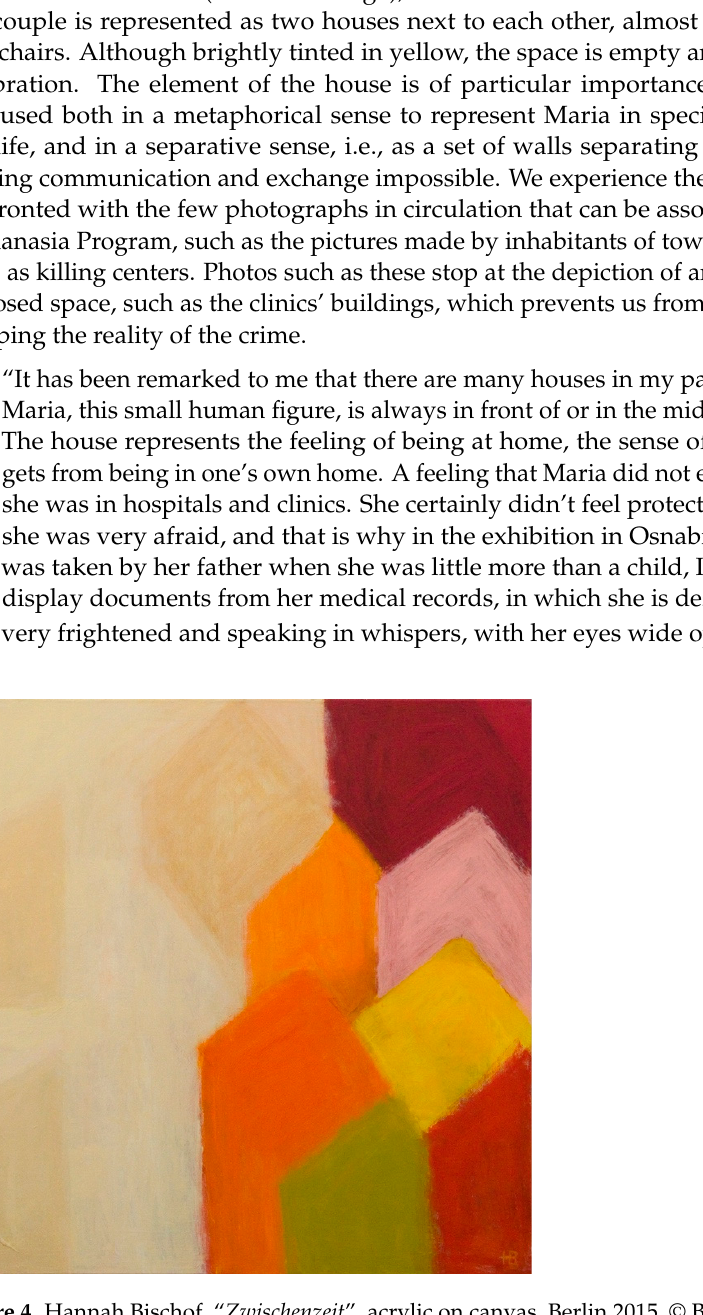
Figure 5. Hannah Bischof, “ Cardiazol ”, acrylic on canvas, Berlin 2015, © Ben Bischof. On 24 June 1939, Maria was admitted to the Elisabeth Herzberge hospital at the request of her family doctor. Here she remained until she was transferred to Neuruppin in 1941. There were no visitor’s rooms and no café or recreation rooms; patients sat on long benches in long corridors, which opened onto windows or a glass door leading outside, to the hospital’s avenues.